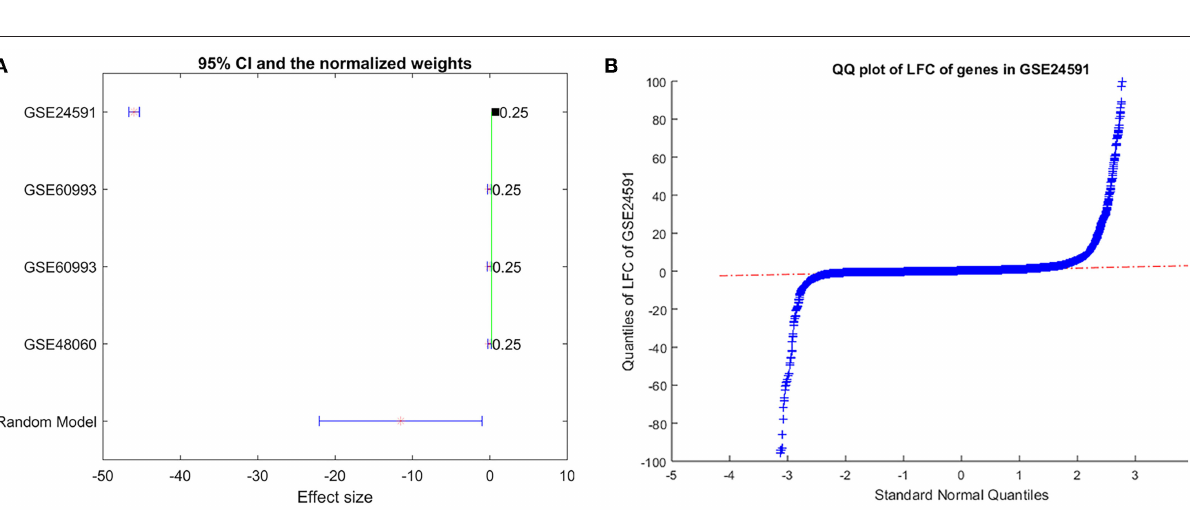
Frontiers in Cardiovascular Medicine |